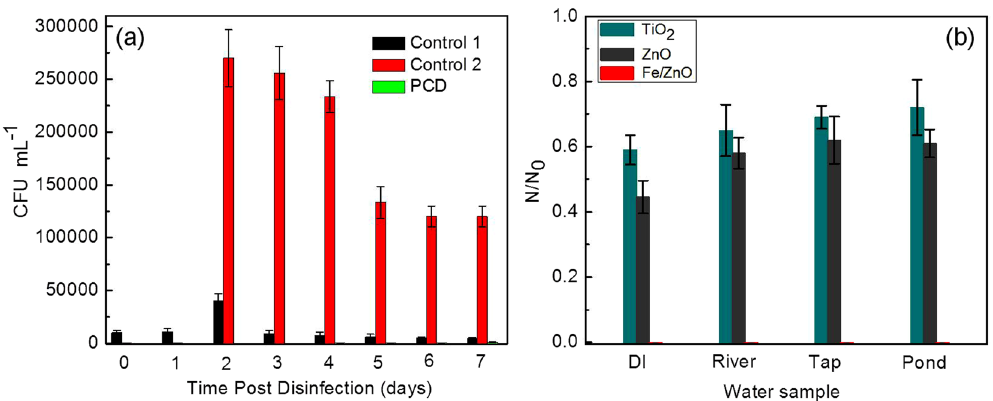
Figure 8. ( a ) Post-disinfection reactivation efficiency of MDR E. coli and ( b ) Effect of different photocatalysts on the relative reduction in the MDR E. coli cell count (N/N 0 ) in real water samples after 180 min of solar irradiation at a catalyst loading of 500